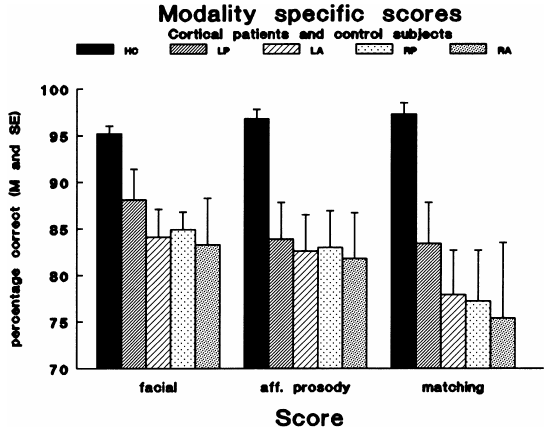
Fig. 1. Percentage correct (mean and standard error) for the modality-specific subscores (facial expressions, affective prosody, matching) of the different cortical patient groups (RA = patients with right anterior damage; RP = patients with right posterior dam- age; LA = patients with left anterior damage; LP = patients with left posterior damage) and healthy controls